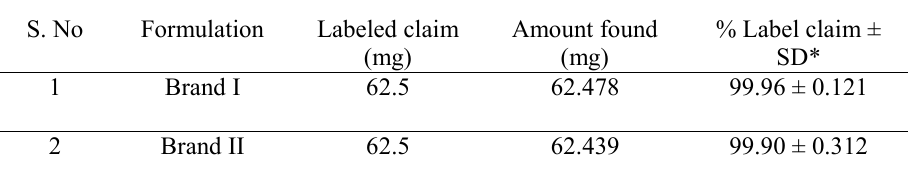
Table 2. Analysis of commercial formulations